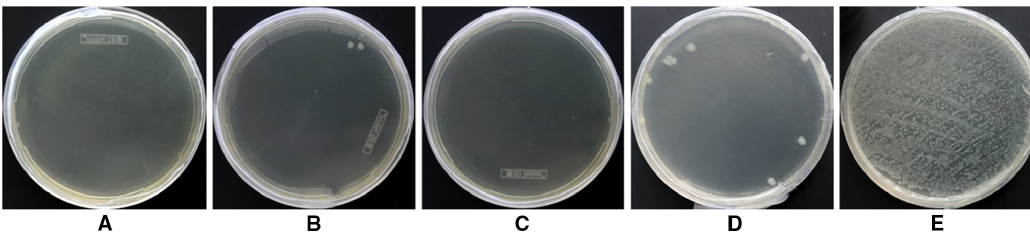
Figure 23. ( a ) Zone of inhibition ( E. coli ) on the 3% Zinc acetate on the number of CFU after 24